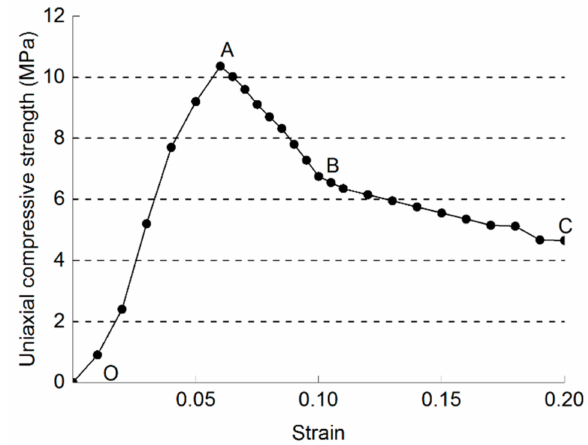
Figure 5. The stress-strain curve of the high-water material in the